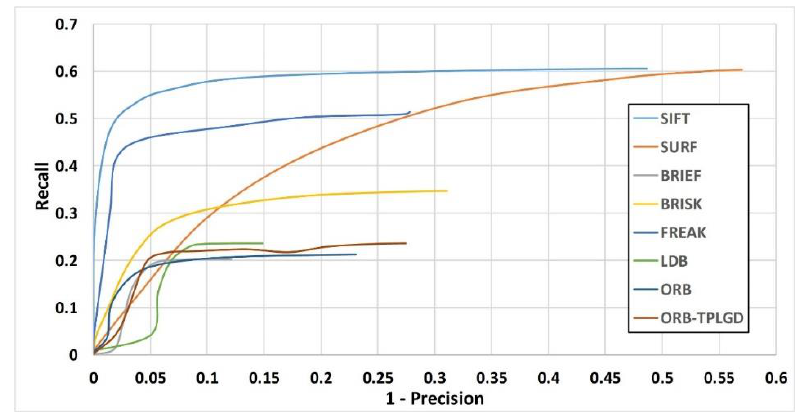
Figure 13. Matching e ff ect based on the selected SAR images.